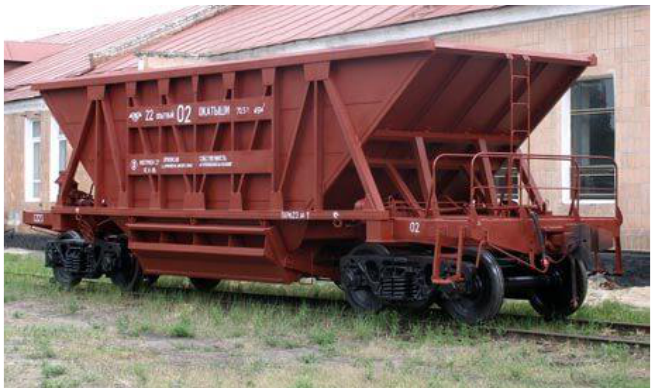
Figure 3. Hopper wagon.